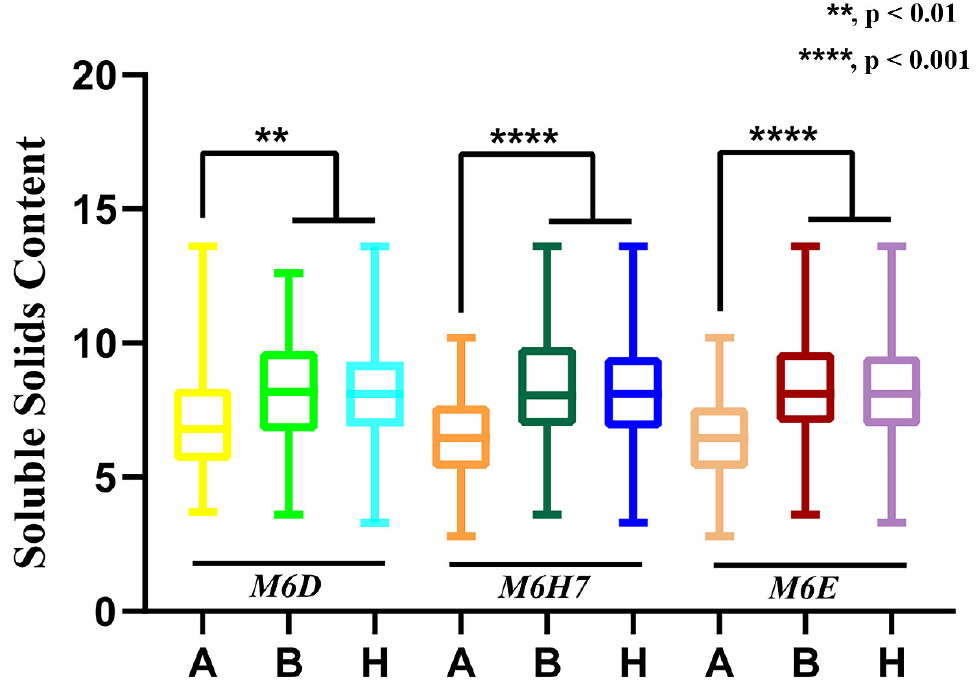
Figure 7. Three markers were used to conduct a correlation analysis between phenotypes and genotypes. The X -axis represents the three genotypes (A, B and H) of CAPS markers, and the Y -axis represents the value of SSC. Asterisk symbols (**, ****) represents the statistical significance; **, p < 0.01, ****, p < 0.001.